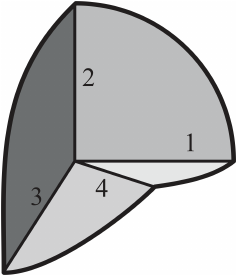
Figure 2. A degree-4 vertex shown in a partially folded state (Lang, 2017). It has a complete fold-angle set of ((1 , − 90 ◦ ), (2 , − 135 ◦ ), (3 , − 90 ◦ ), (4,135 ◦